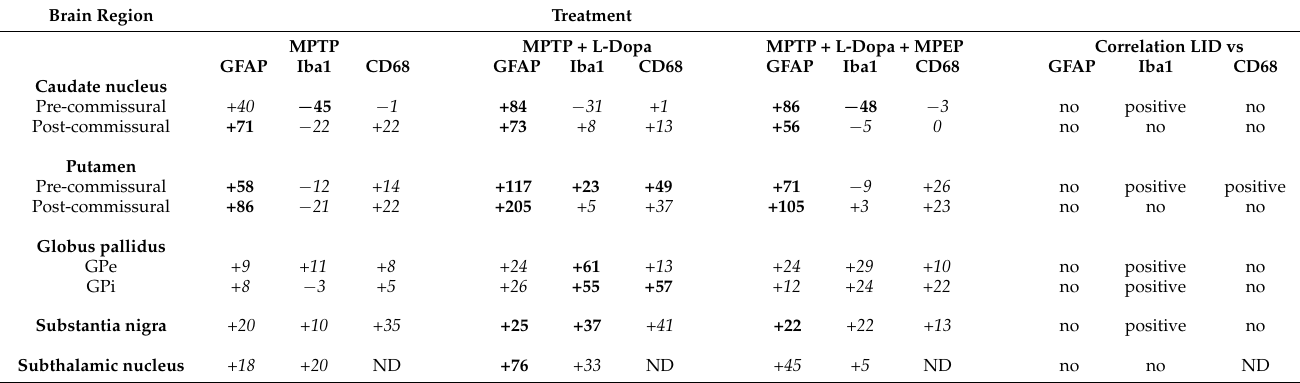
Table 2. Comparative results for the astrocytes marker GFAP and microglial markers Iba1 and CD68 levels in the brain of the experimental groups of MPTP monkeys compared to controls and their relationship with L-Dopa-induced dyskinesias (LID) and their prevention with